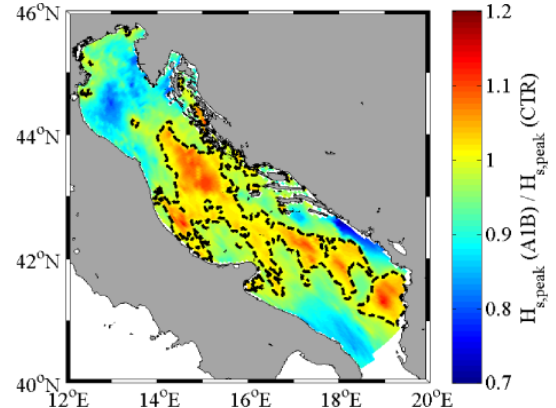
Fig. 15. 30-yr return period H s,peak based on the GPD. Pattern of the H s,peak ratio between A1B and CTR results. The black dashed line shows the isoline